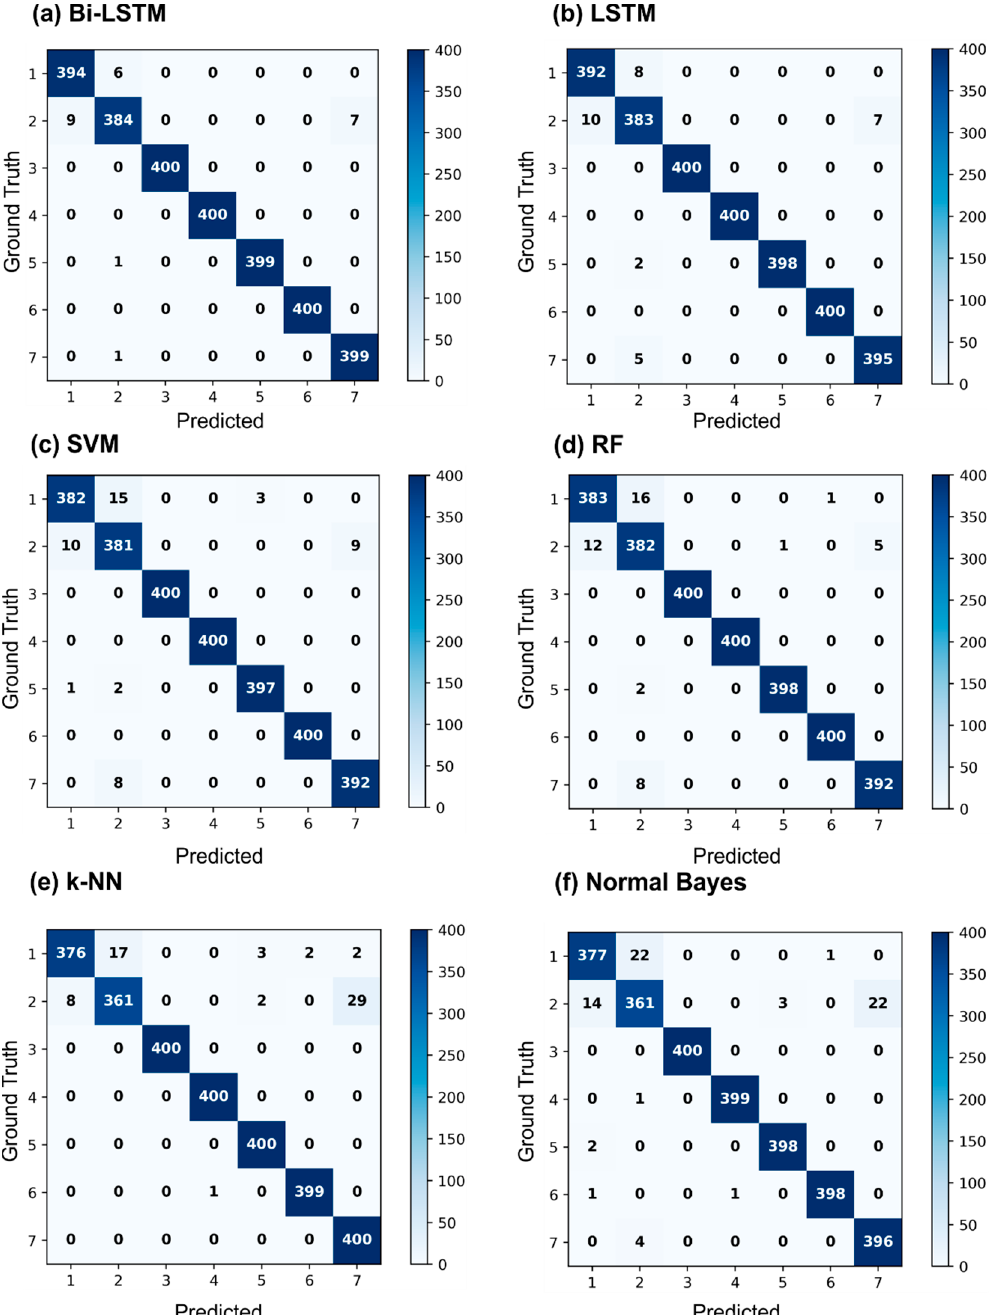
Figure 14. Confusion matrices of land use and land cover classification using different algorithms ( a ) Bi-LSTM, ( b ) LSTM, ( c ) support vector machines (SVM), ( d ) random forest (RF), ( e ) k-NN, and ( f ) Bayes. The analyzed classes were: (1) rice crops, (2) fallow period between crops, (3) bodies of water (rivers, lakes, and reservoir), (4) riparian forest/reforestation, (5) grassland, (6) flooded grassland, and (7) other types of crops. We disregard the areas of the city using a mask.